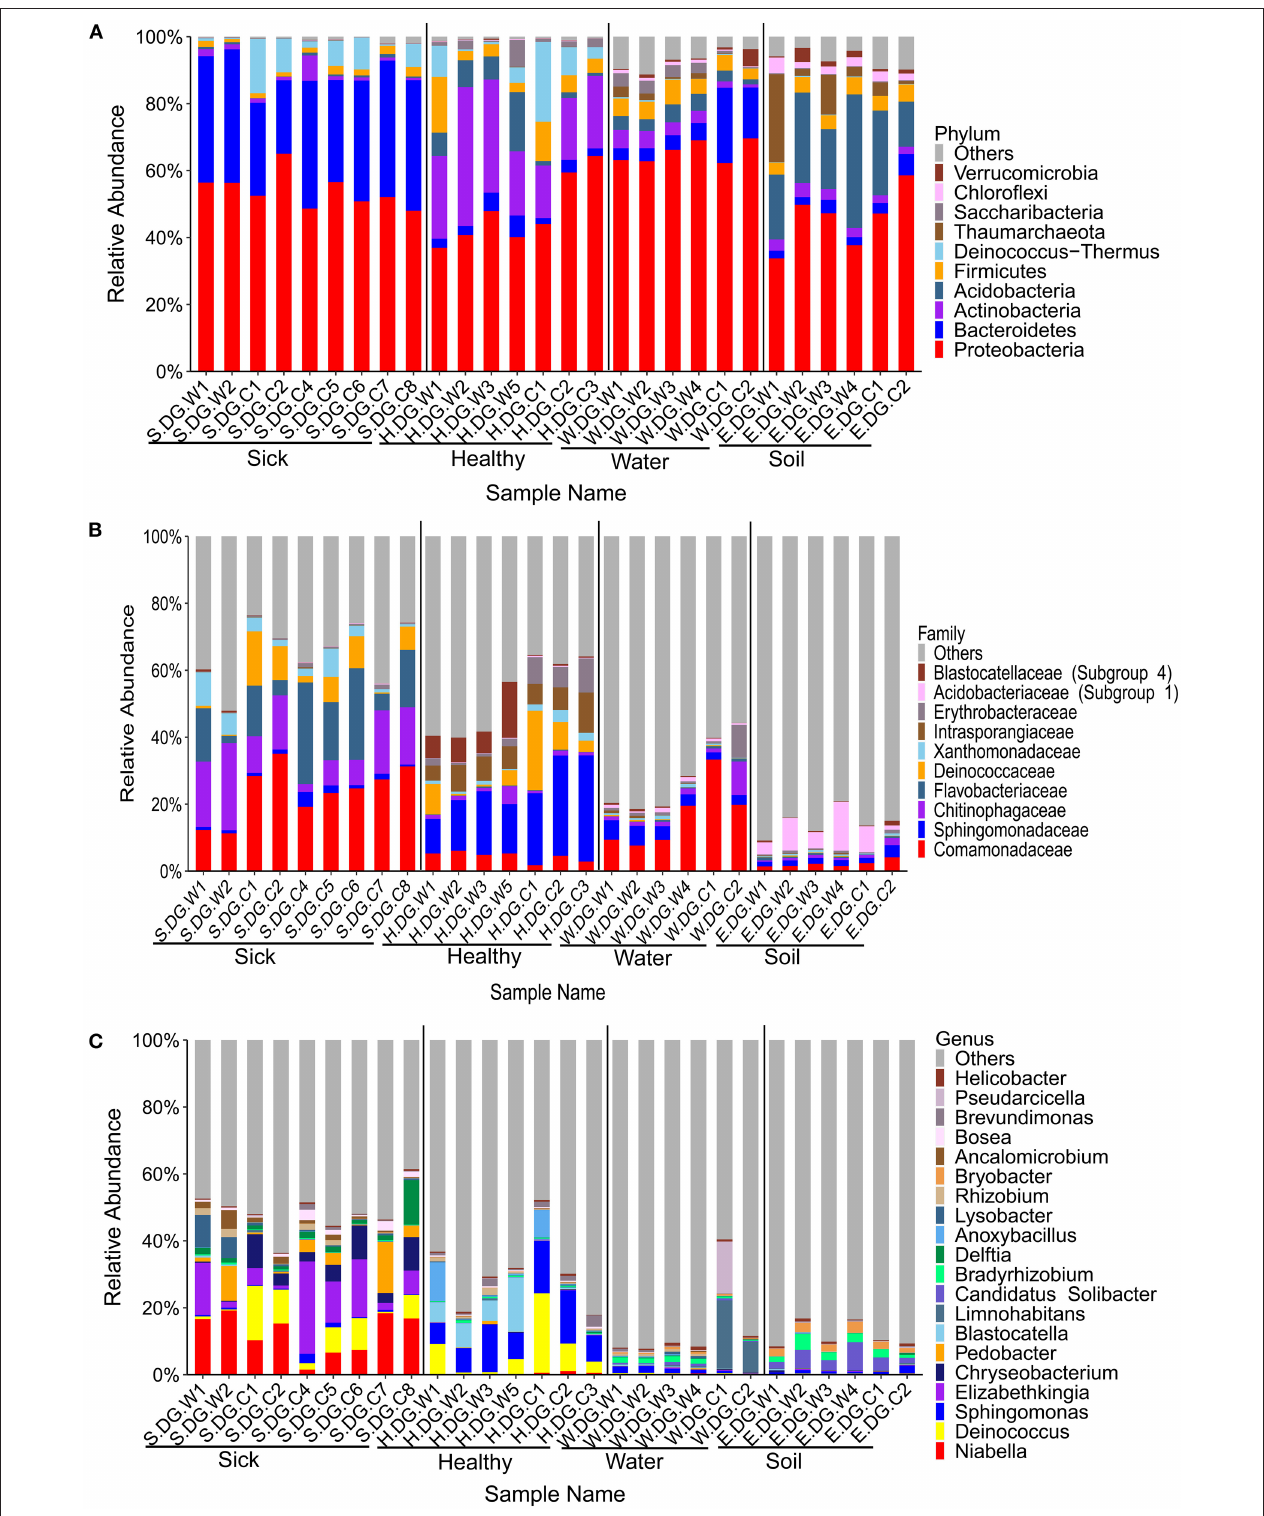
FIGURE 3 | Composition of cutaneous bacteria at the phylum (A) , family (B) , and genus (C) levels. The taxa with abundance of top 10, 10, 20 were showed at the phylum, family, and genus levels. The rest taxa with low abundance were included in “Others.” Group boundaries were separated by black vertical lines.